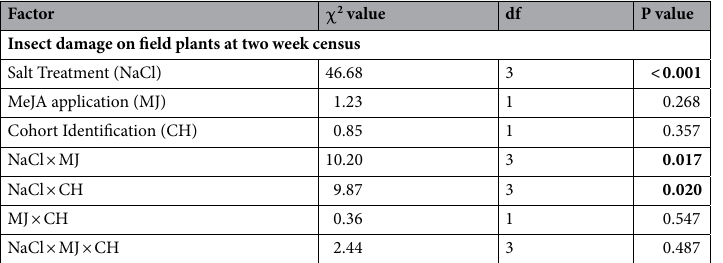
Factor χ 2 value df P value Insect damage on field plants at two week census Salt Treatment (NaCl)